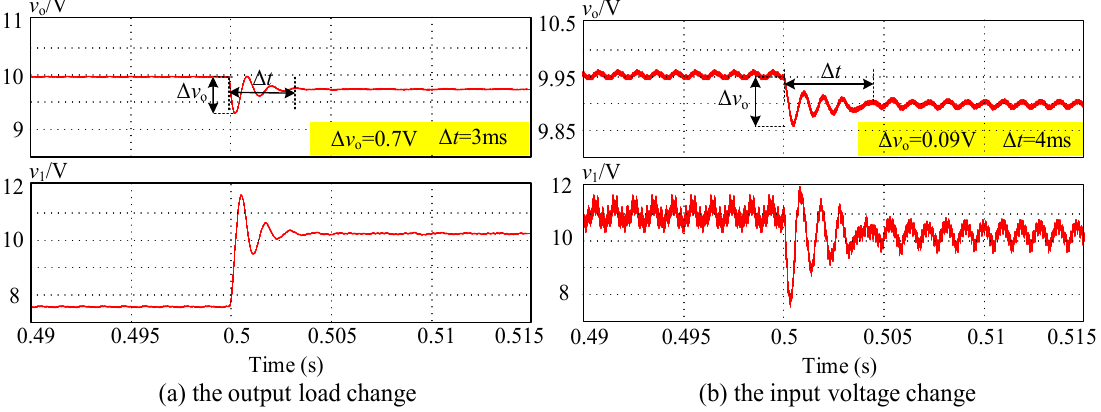
Figure 10. Waveforms of v 1 and v o under the CC&OV-PT control when the output load and input voltage changes.